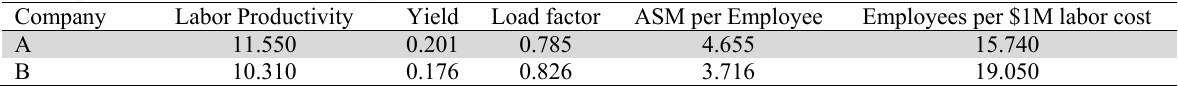
Labor productivity ratio for company A and B